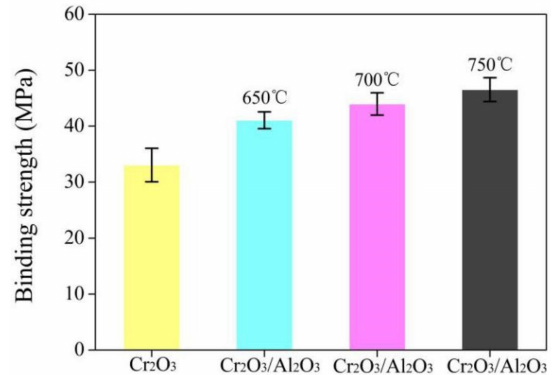
Figure 10. Bond strength curves of the Cr 2 O 3 and Al 2 O 3 /Cr 2 O 3 composite coatings heat-treated at different